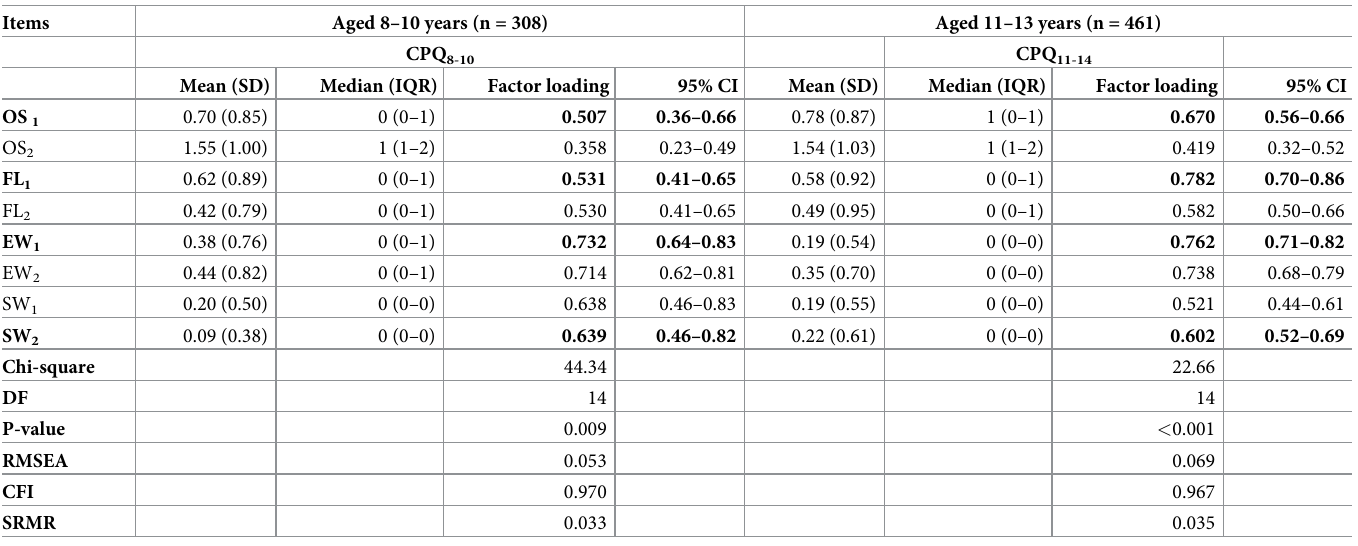
Table 2. Confirmatory factor analysis of the 8-item CPQ 8-10 and CPQ 11-14